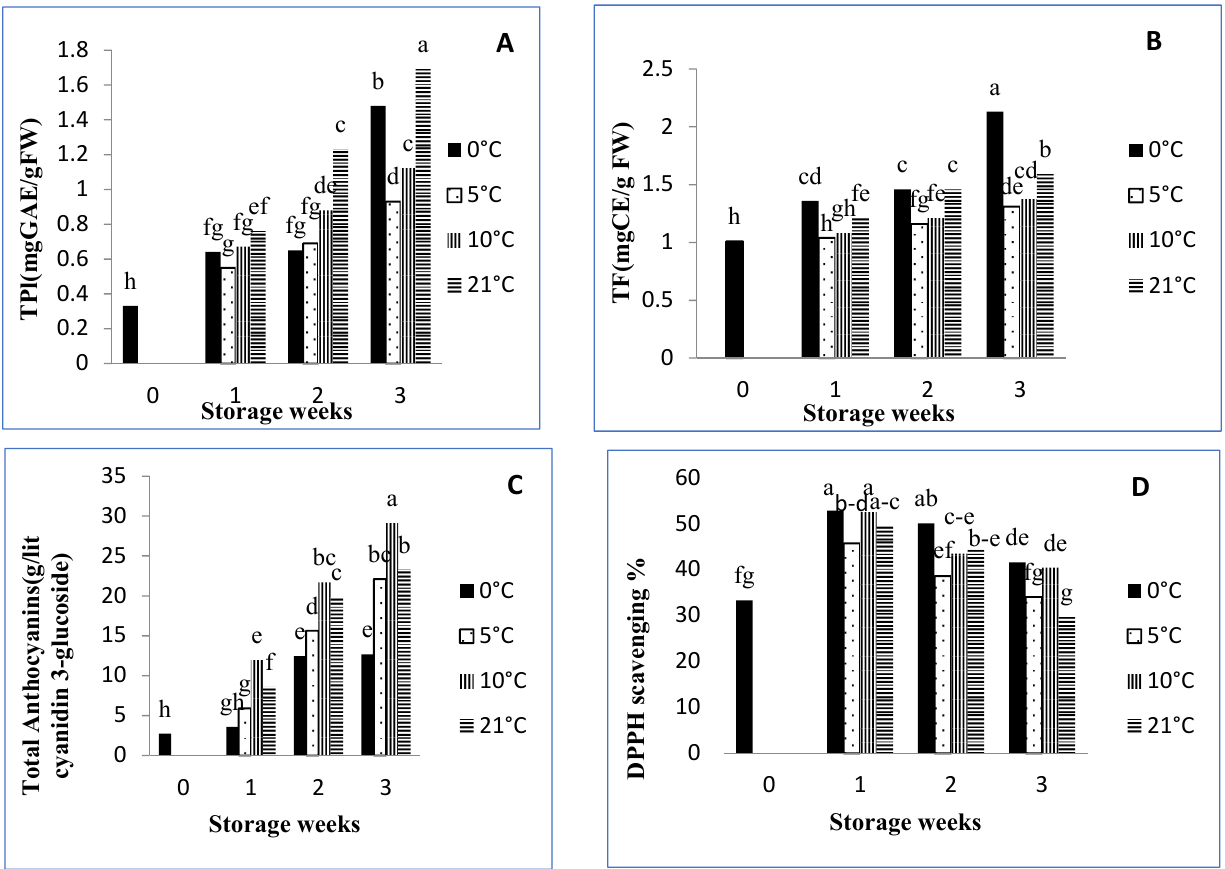
Figure 3. Effects of different storage temperatures on total phenolic (TP) content ( A ), total flavonoid (TF) content ( B ), total anthocyanin content ( C ), and DPPH scavenging percent ( D ) of cornelian cherry fruits treated with 1% chitosan. Different letters on bars indicate significant differences among storage temperatures at p < 0.05 by Duncan’s test.